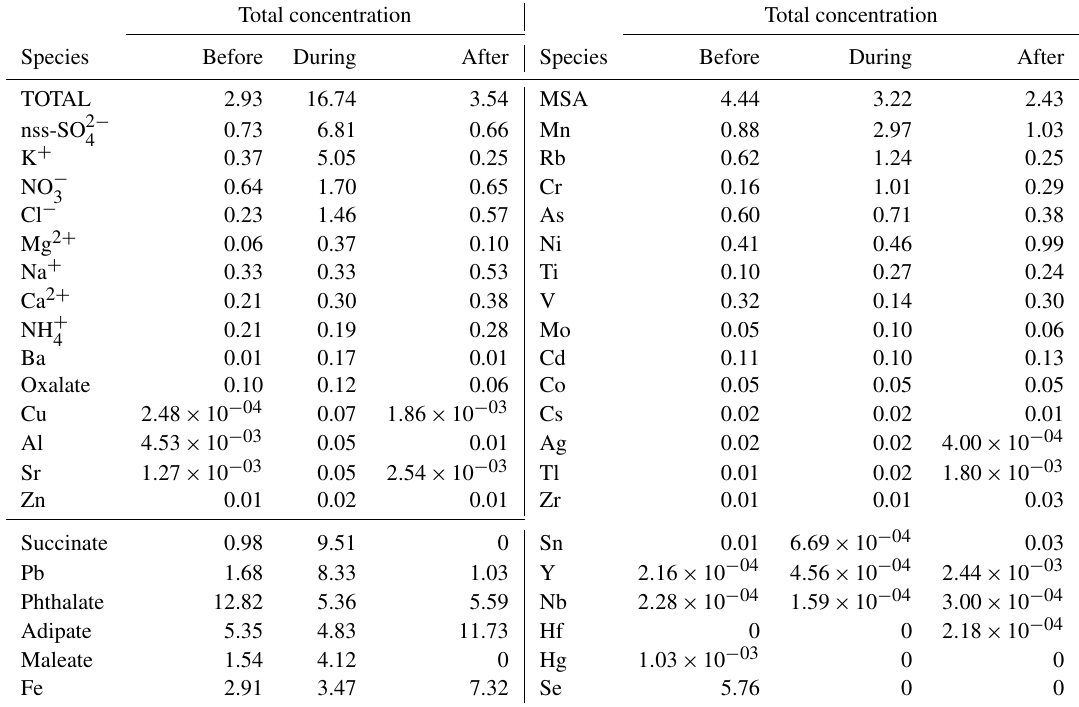
Table 1. Summary of total and speciated concentrations before, during, and after the firework event. Species are divided based on units (total to Zn: µgm − 3 ; succinate to Se: ngm − 3 ). Total concentration